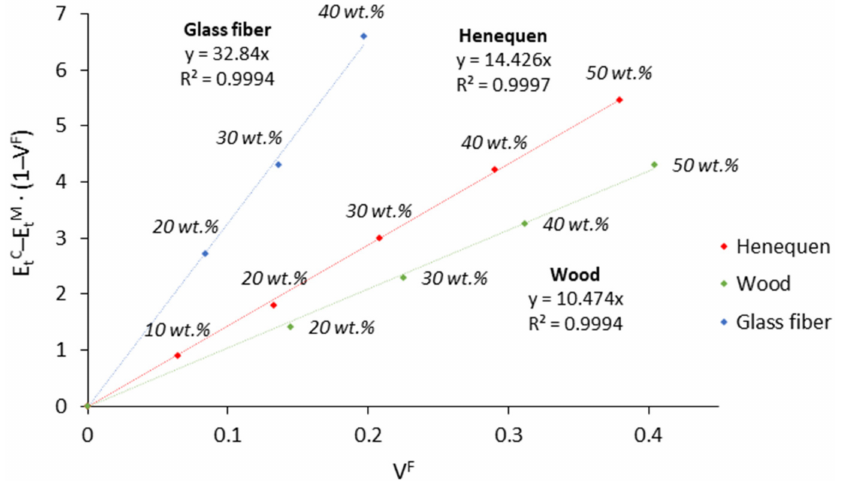
Figure 5. FFMF of henequen fibers, wood fibers, and glass fibers in polypropylene